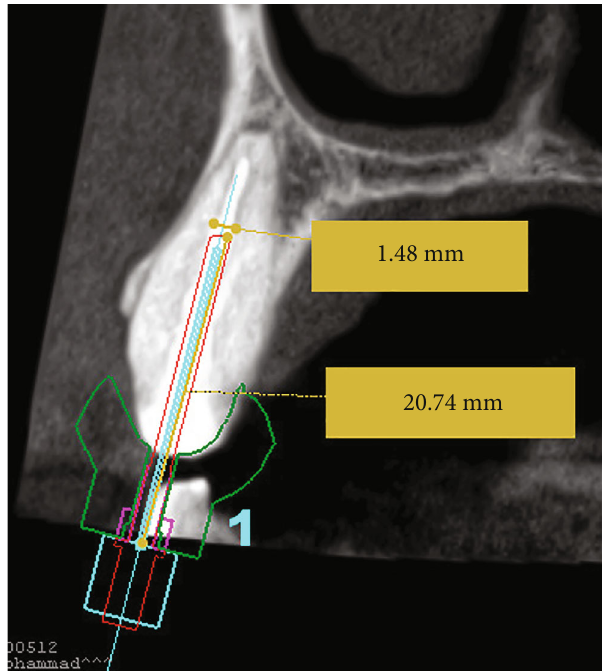
Figure 3: Virtual planning of fi ber post removal. The drill was positioned along the long axis of the fi ber post set up to its apical